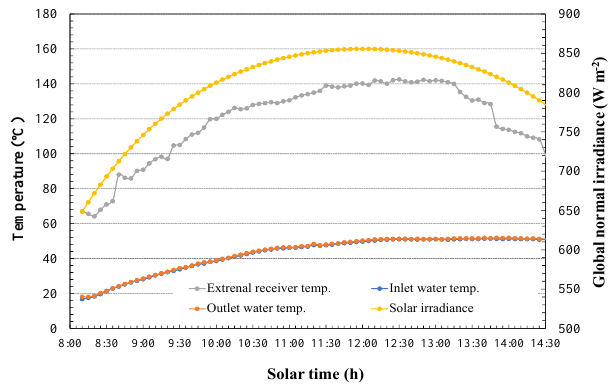
Figure 21. Variation of the system temperature as a function of time with a collector with a higher reflectivity.